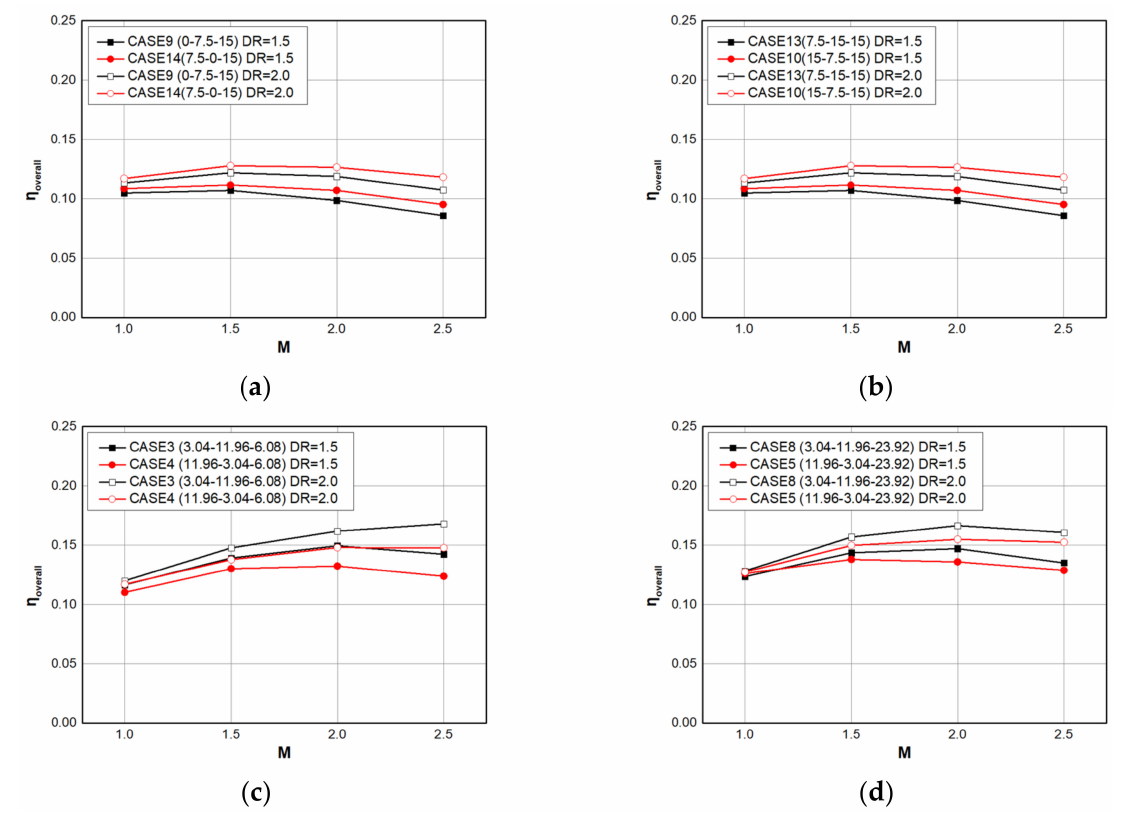
Figure 6. Overall averaged FCE for the effects of asymmetric lateral expansion angle: ( a ) (0-7.5-15) and (7.5-0-15) holes; ( b ) (7.5-15-15) and (15-7.5-15) holes; ( c ) (3.04-11.96-6.08) and (11.96-3.04-6.08) holes; ( d ) (3.04-11.96-23.92) and (11.96-3.04-23.92)